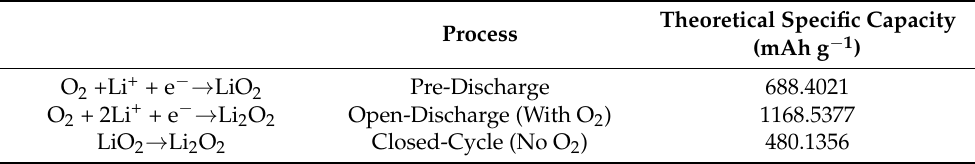
Figure 1. Schematic representations of a closed “Li–O 2 ” battery based on the conversion of LiO 2 and Li 2 O 2 (LiO 2 + e − + Li + ↔ Li 2 O 2 ). Table 1. The theoretical discharge capacity of three reaction paths.